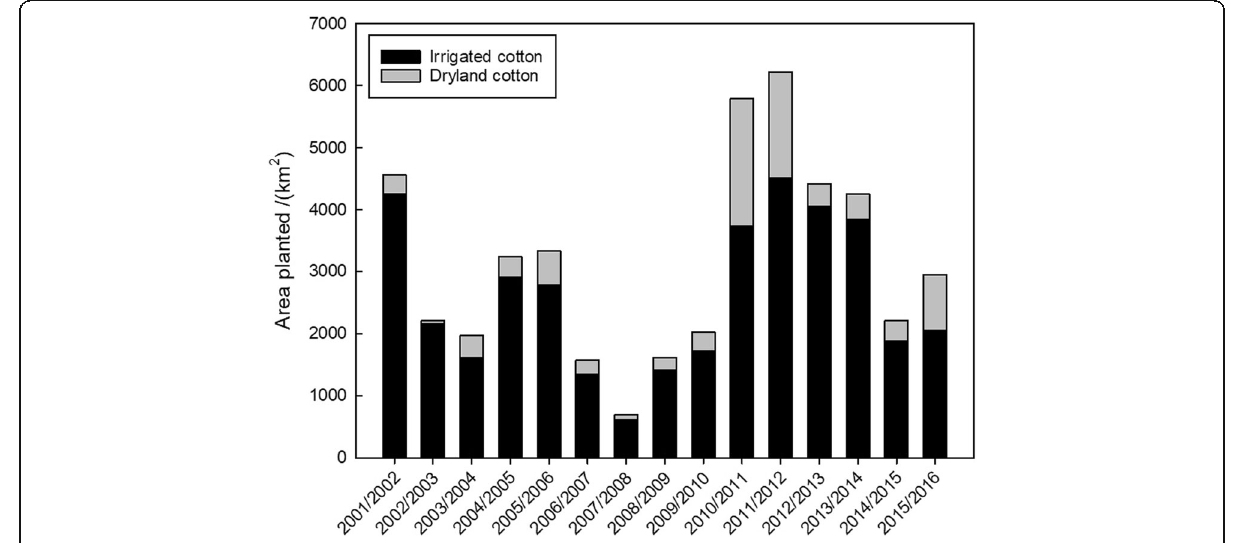
Fig. 1 Area planted for irrigated and dryland cotton in Australia (Anon